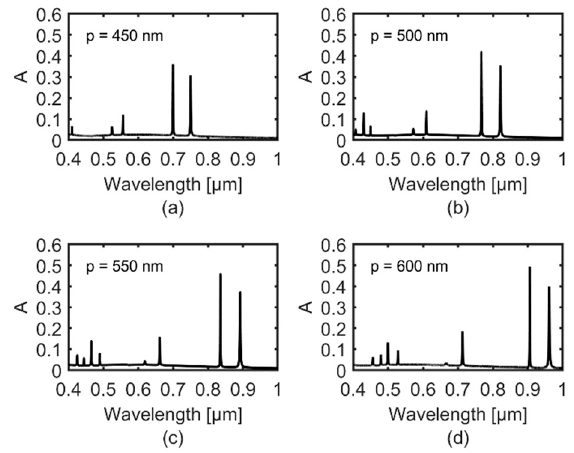
Figure 5. Absorption spectra of the proposed structure under varying grating period for normally incident TE polarized plane wave. The waveguide Ta 2 O 5 thickness t Ta2O5 , and polymethyl-methacrylate (PMMA) pillars height t PMMA are fixed at 150 nm and 600 nm, respectively.